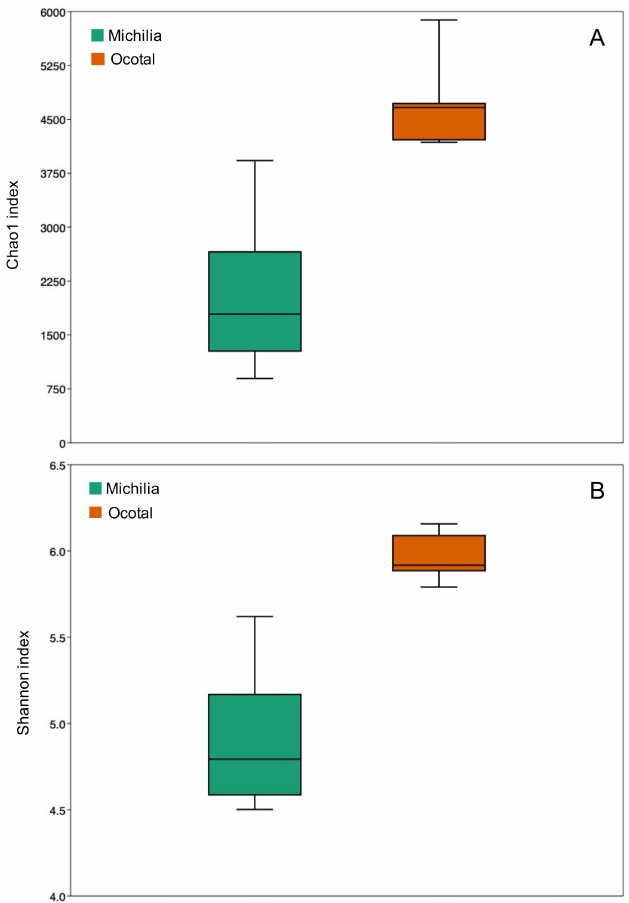
Figure 1. Boxplots of ( A ) Chao1 richness index and ( B ) Shannon alpha diversity index for the bacterial microbiota from two populations of Mexican wolves (Canis lupus baileyi) in Michilia (M, 23 ◦ N) and Ocotal (O, 19 ◦ N), Mexico.